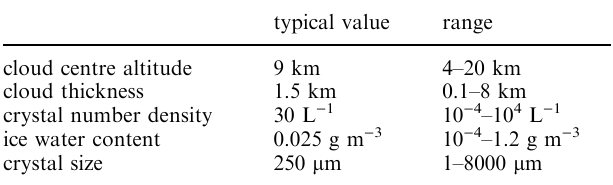
Table 1. Physical properties of cirrus (Dowling and Radke,